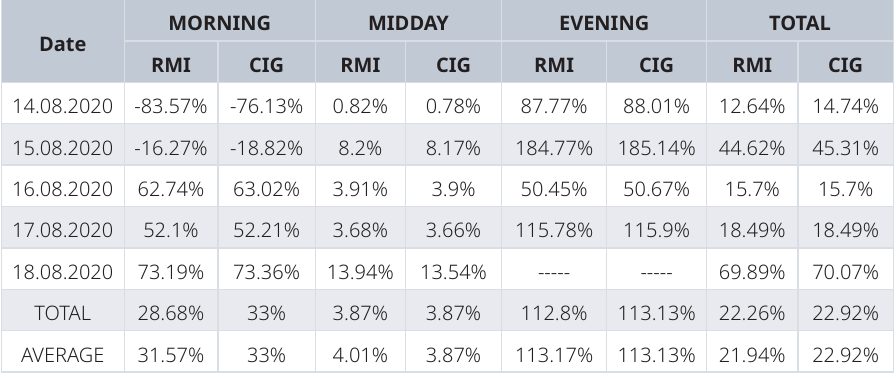
Table 4. Efficiency gain of tracking panel in reference to stationary panel.